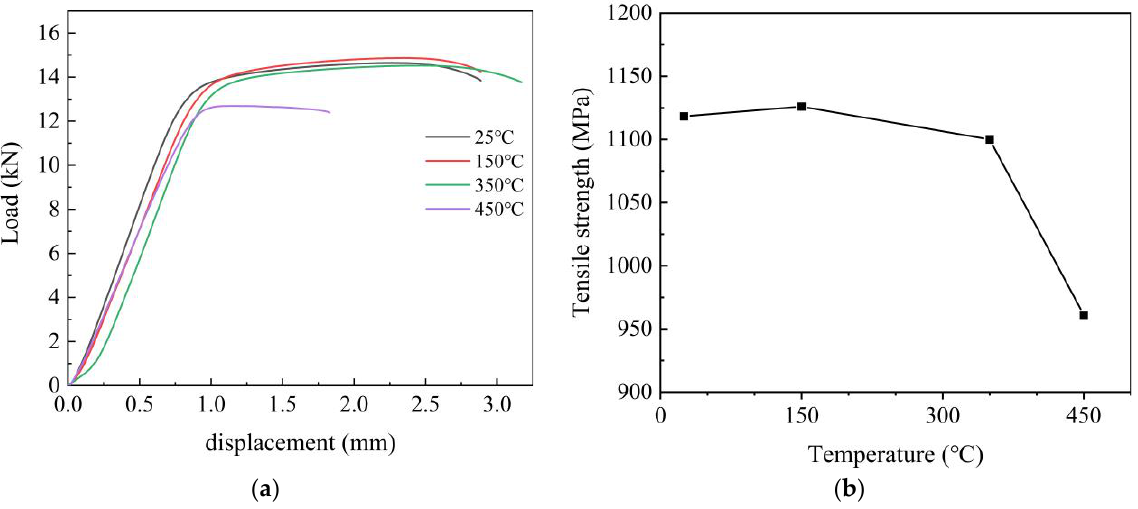
Figure 8. Load displacement curves and tensile strength of C17200 beryllium copper alloy at different temperatures. ( a ) Load displacement curves at different temperatures; ( b ) tensile strength at different temperatures.